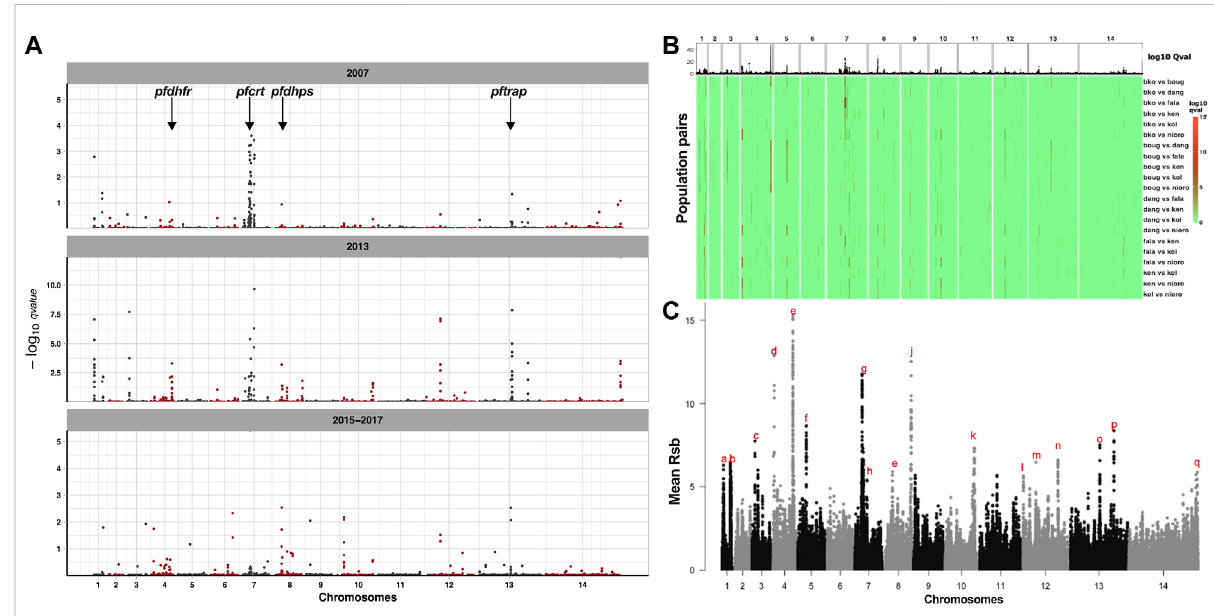
FIGURE 5 Signatures of positive selection in the genomes of temporal and geo-temporal populations of P. falciparum in Mali. (A) Manhattan plots of genome-wide − log10 q-values of standardized integrated haplotype score (iHS) for temporal populations from Faladje, showing positions of genes fordrug-resistance-associatedloci, pfdhfr , pfcrt ,and pfdhps, andtheantigen pftrap. Eachrowrepresentstheyearofsampling,showing2007,2013, and combined 2015 – 2017 samples. (B) Heatmap of -log10 q-values of cross population extended haplotype homozygosity test between pairs of geo-temporal populations shown in rows with abbreviated names for Kolle (kol), Bougoula-Hameau (boug), Faladje (fala), Kenieroba (ken), Bamako (bko), Dangassa (dang), and Nioro (nioro). (C) Combined Rsb scores of SNPs across the P. falciparum genome over all pairwise comparison of seven geo-temporal populations. The top genomic regions harboring SNPs with a mean Rsb > 5 are labeled alphabetically from chromosome 1 – 14. The genomic coordinates and genic loci within these regions are given in Table